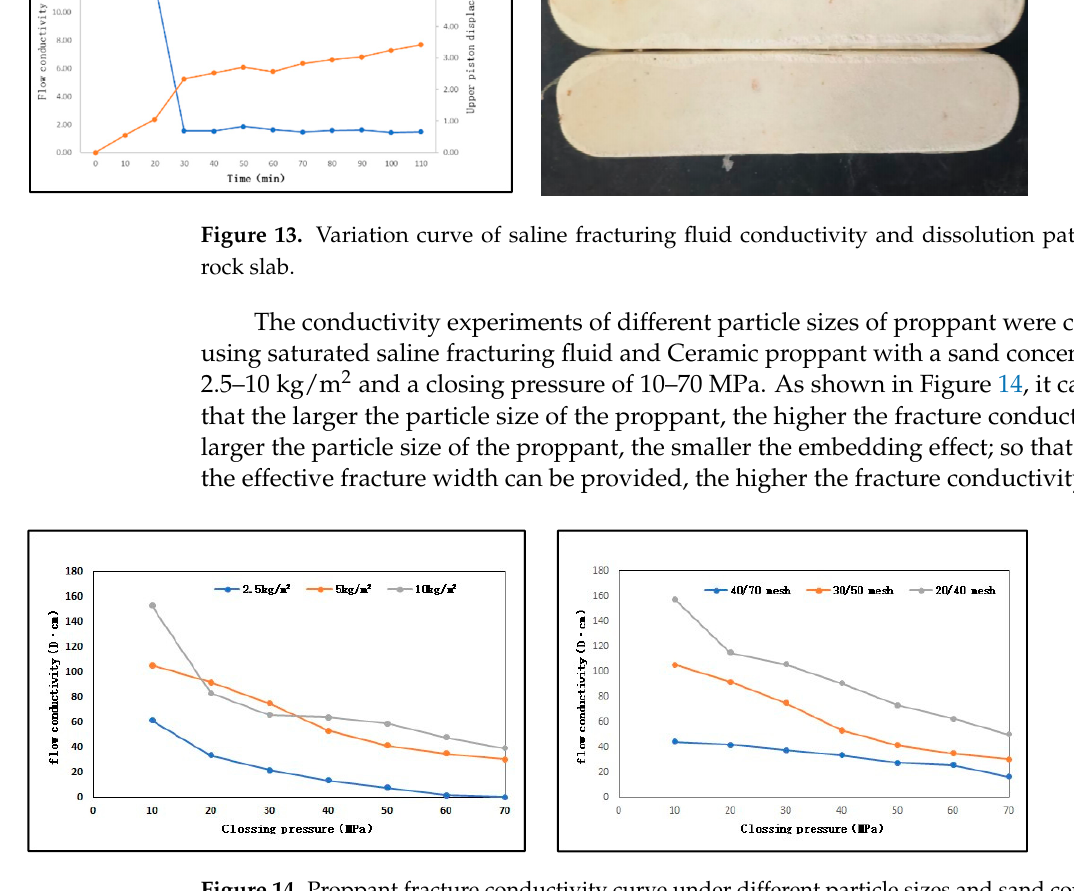
Figure 12. Variation curve of clearwater fracturing fluid conductivity and dissolution pattern of the rock slab.